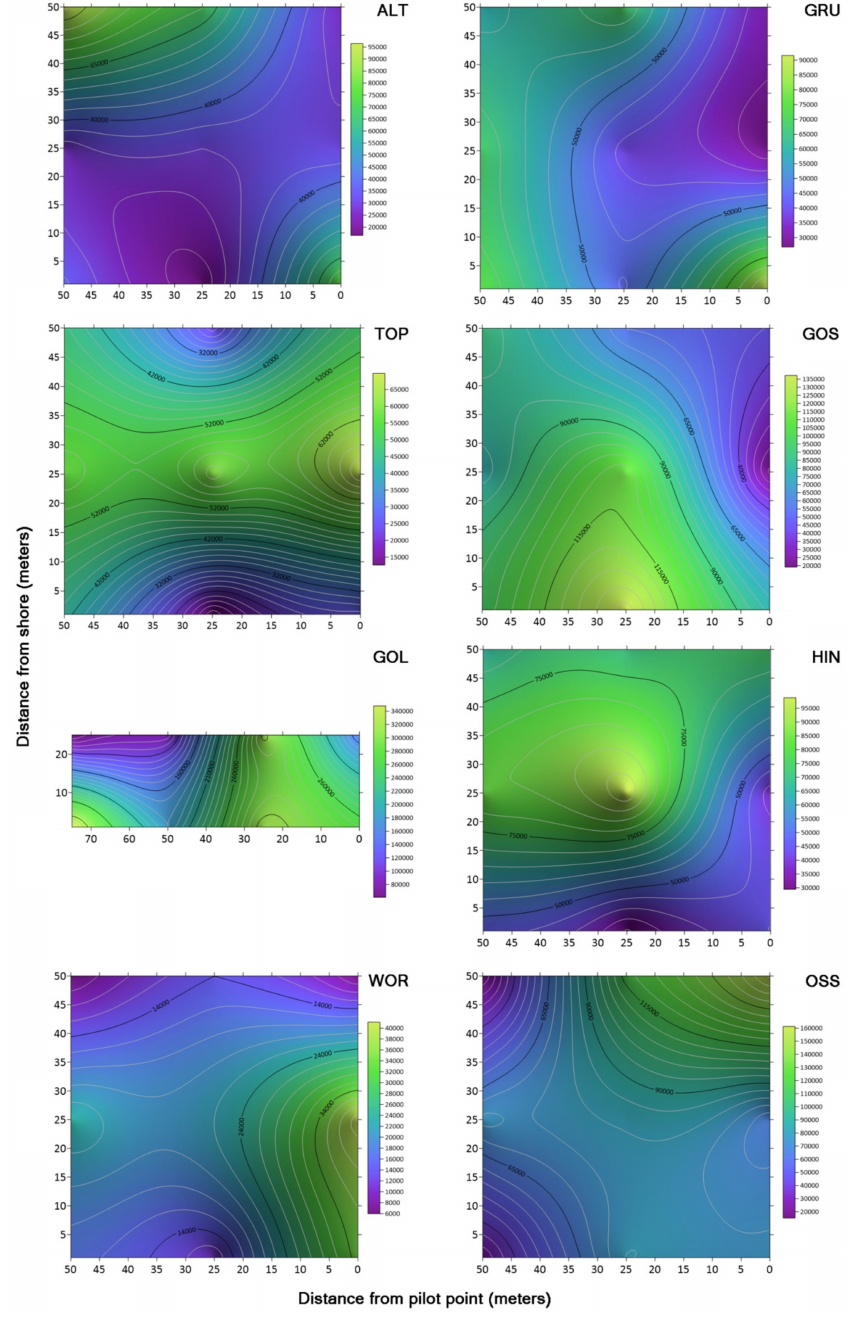
Figure 5. Contour maps of the spatial distribution of bacteria (meters) cultured from each of the Austrian lakes on TSA agar media (CFU/mL). These contour maps were created using the Surfer 15 software using the concentration data for each sample site in each lake. The small area mini-lake, Gosaulacke (GOL), had an alternate sample collection grid. Sample collections were plotted on a Cartesian